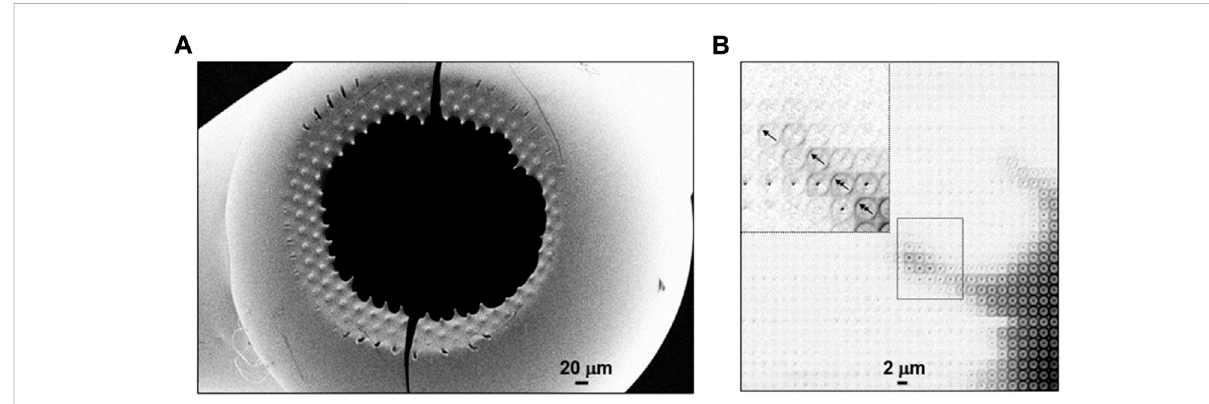
FIGURE 6 (A) SEMimageofhollowlysozymesolutionresiduedetachedfrompillaredSHSsubstraterevealingpinningpoints.Adaptedfrom:(Accardoetal., 2010;Accardoetal.,2011b). (B) Densitymapbasedonmesh-scanoftwopinningpointsfrom β -amyloid(1 – 42)solutionresiduethrough~1 μ mfocal spot. Adapted from: (Marinaro et al., 2016). The inset shows the cross- β patterns in the outer part of one of the pinning points with arrows indicating the local fi ber axes orientation. The outermost patterns show enhanced orientational ordering and